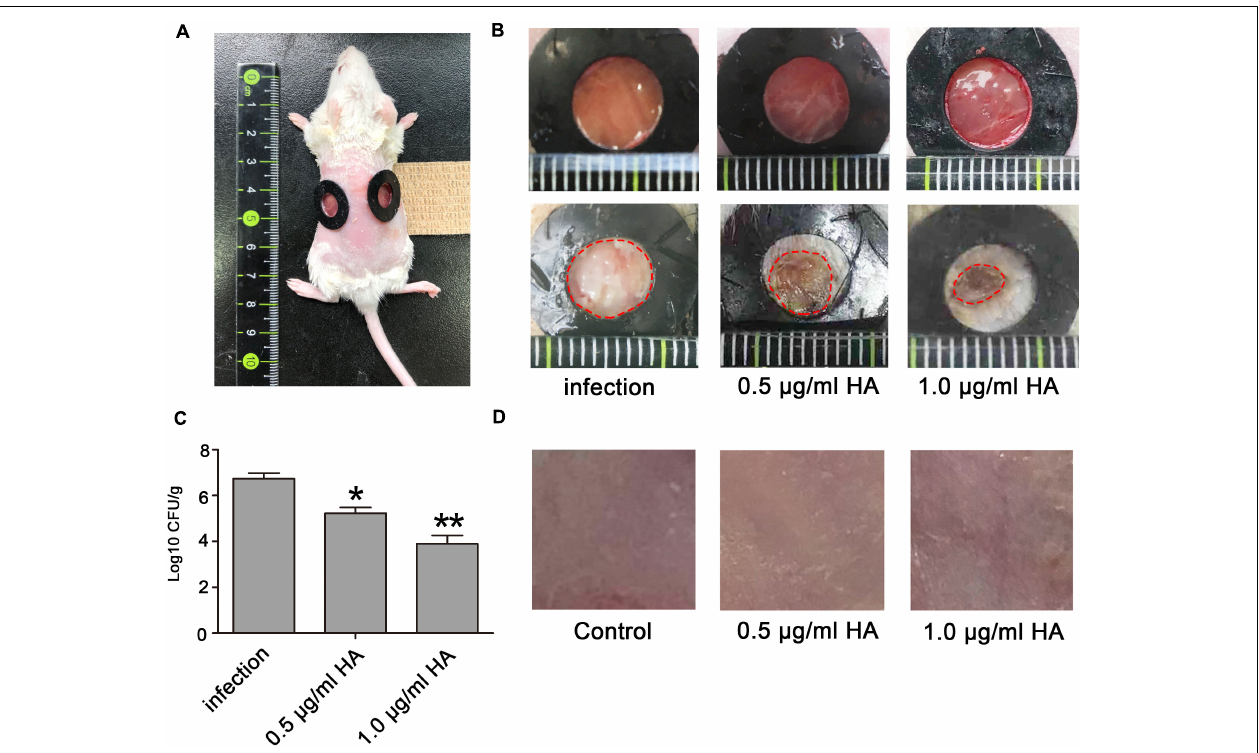
FIGURE 7 | The photodynamic antifungal efficacy of HA in treating cutaneous C. albicans infections. (A) The 0.8 cm diameter wounds were created by removal of the full-thickness skin on the shaved back of the mice. (B) C. albicans skin infections and damage were observed on day 8. The mice in this experiment were divided into three groups: C. albicans infection group ( n = 6), C. albicans infection + 0.5 µ g/ml HA group ( n = 6), and C. albicans infection + 1.0 µ g/ml HA group ( n = 6). In the C. albicans infection group, the mice were just subjected to C. albicans infection without HA addition. In the C. albicans infection + HA groups, 0.5 or 1.0 µ g/ml HA and illumination for 30 min were performed at 30 min post-infection. The treatments in each group were repeated in the following 6 days. On day 8, C. albicans skin infections were evaluated. (C) The fungal burden was evaluated in the infected skin wounds on day 8. The mouse wounds were surgically excised and homogenized in PBS to release C. albicans . After that, the suspensions were subjected to being streaked on YPD agar plates to count CFUs after 24–48 h of incubation at 30 ◦ C. (D) Toxicity of HA was observed in normal mouse skin. 0.5 or 1.0 µ g/ml HA and illumination for 30 min daily were conducted on the shaved back of the mice for consecutive 7 days. ∗ P < 0.05 and ∗∗ P <